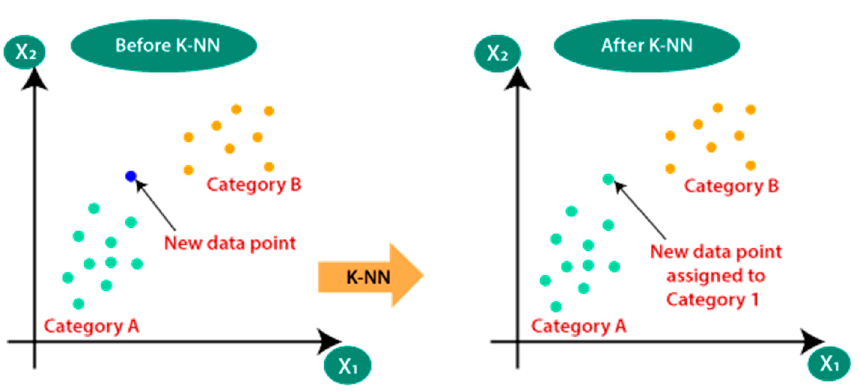
Figure 4. The idea of KNN classification [30].